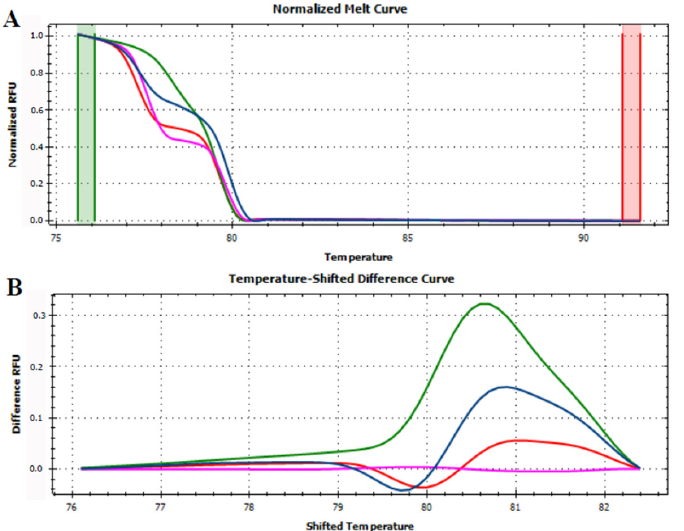
Figure 2. Normalized melt curves ( A ) and temperature-shifted difference curves ( B ) of HRMA of trnL (UAA) intron on fresh fruits. Apple: red, pear: pink, peach: blue and kiwi: green. The reference cluster is pear. The HRMA has been carried out on three independent replicates of each sample and the most representative curve of each sample is reported in the graph.